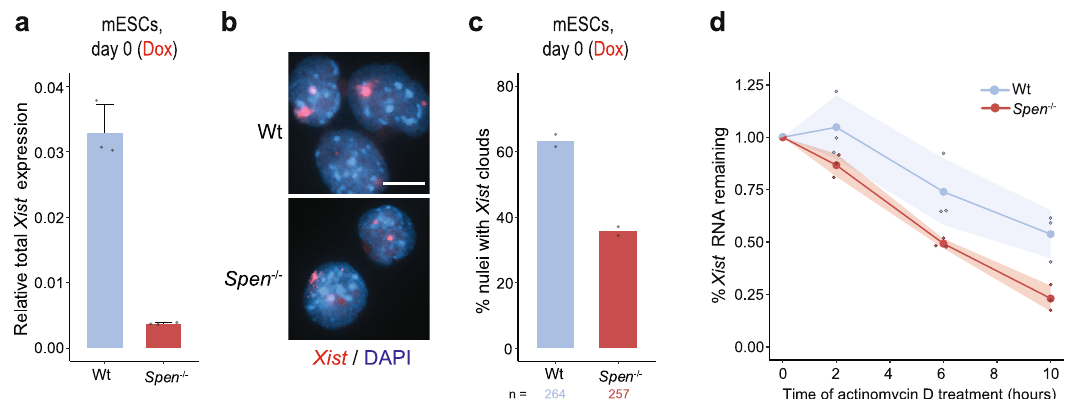
Fig. 4 SPEN plays a role in Xist RNA stability. a Relative total Xist expression in undifferentiated Wt and Spen − / − ESCs upon Xist induction with doxycycline for 4 days. n = 3 biological replicates per condition. Average expression ± SD. Reference gene: Beta - actin . b Xist RNA FISH (red) of undifferentiated Wt and Spen − / − ESCs treated with doxycycline to induce Xist expression. DNA is stained with DAPI (blue). Scale bar: 10 µ m. c Quanti fi cation of ( b ), displaying the percentage of nuclei with Xist clouds. Average percentage, n = 2 biological replicates per condition, the total number of counted nuclei is indicated. d Percentage of Xist RNA remaining at different time points of actinomycin D treatment ( t = 0, 2, 6 and 10 h) in undifferentiated Wt and Spen − / − ESCs treated with doxycycline. Normalized relative expression to t = 0 ± SD, shading represents the SD, n = 3 biological replicates per condition. Reference gene: Beta - actin